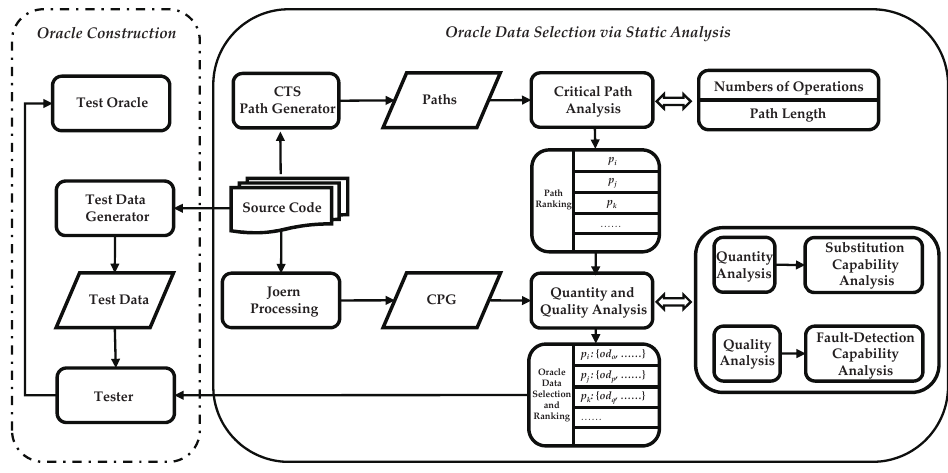
Figure 1. Overview of Our